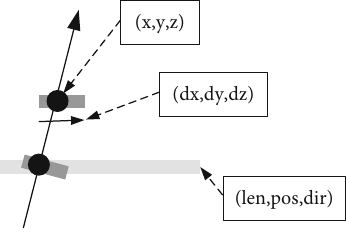
Figure 4: Data structure of the detection vector and underground